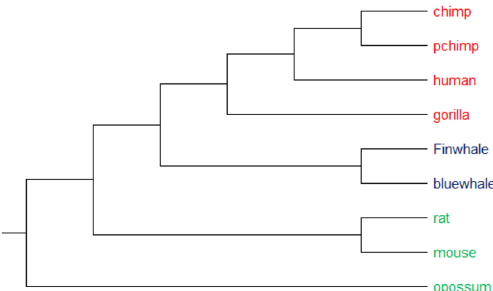
Figure 7. The phylogenetic tree of 9 sequences of NADH Dehydrogenase 5 protein constructed by our method